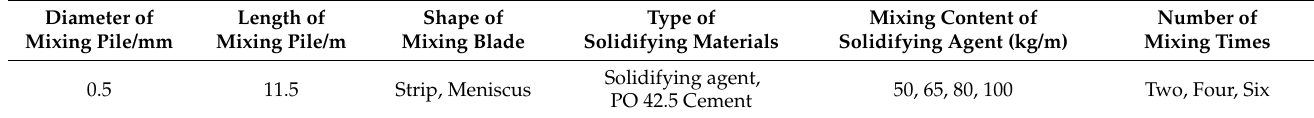
Figure 1. Deep mixing pile machine used in this study.